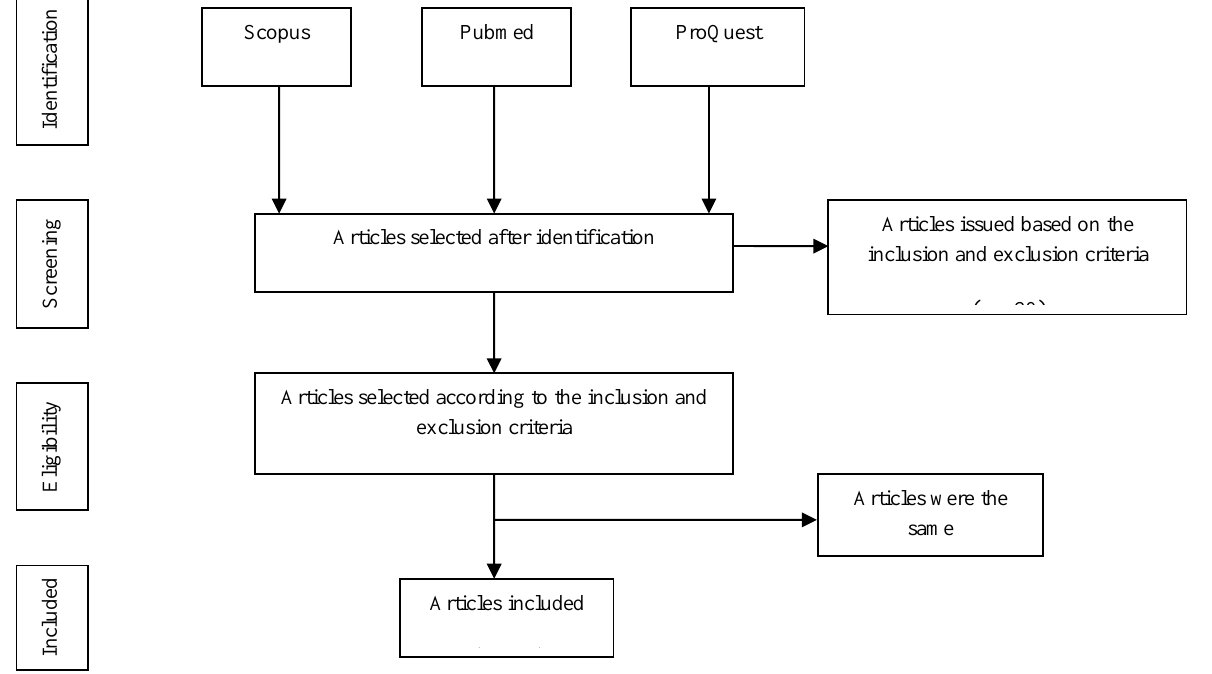
Figure 1 – Flowchart of the Inclusion